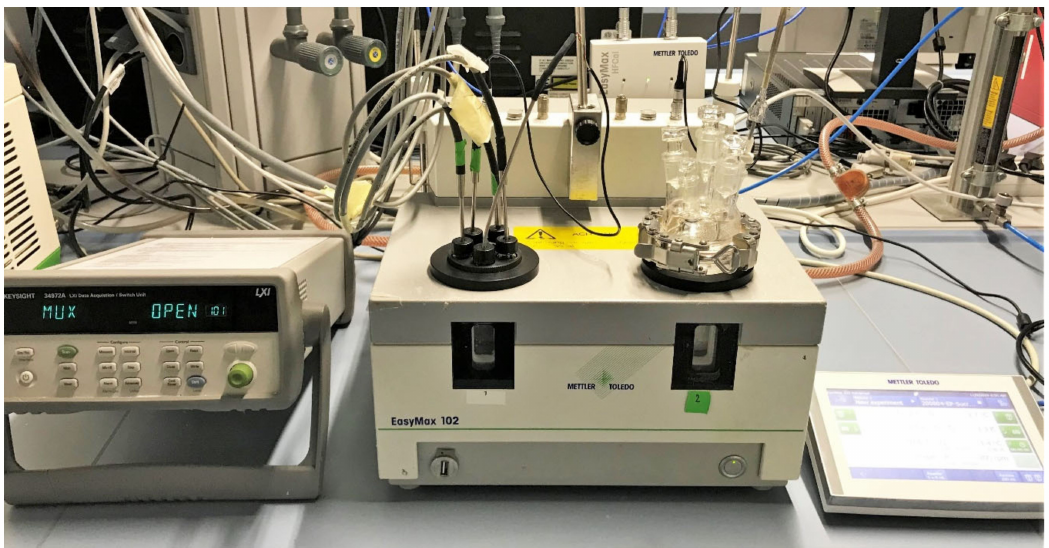
Figure 6. Picture of stability testing device “HSLU”.